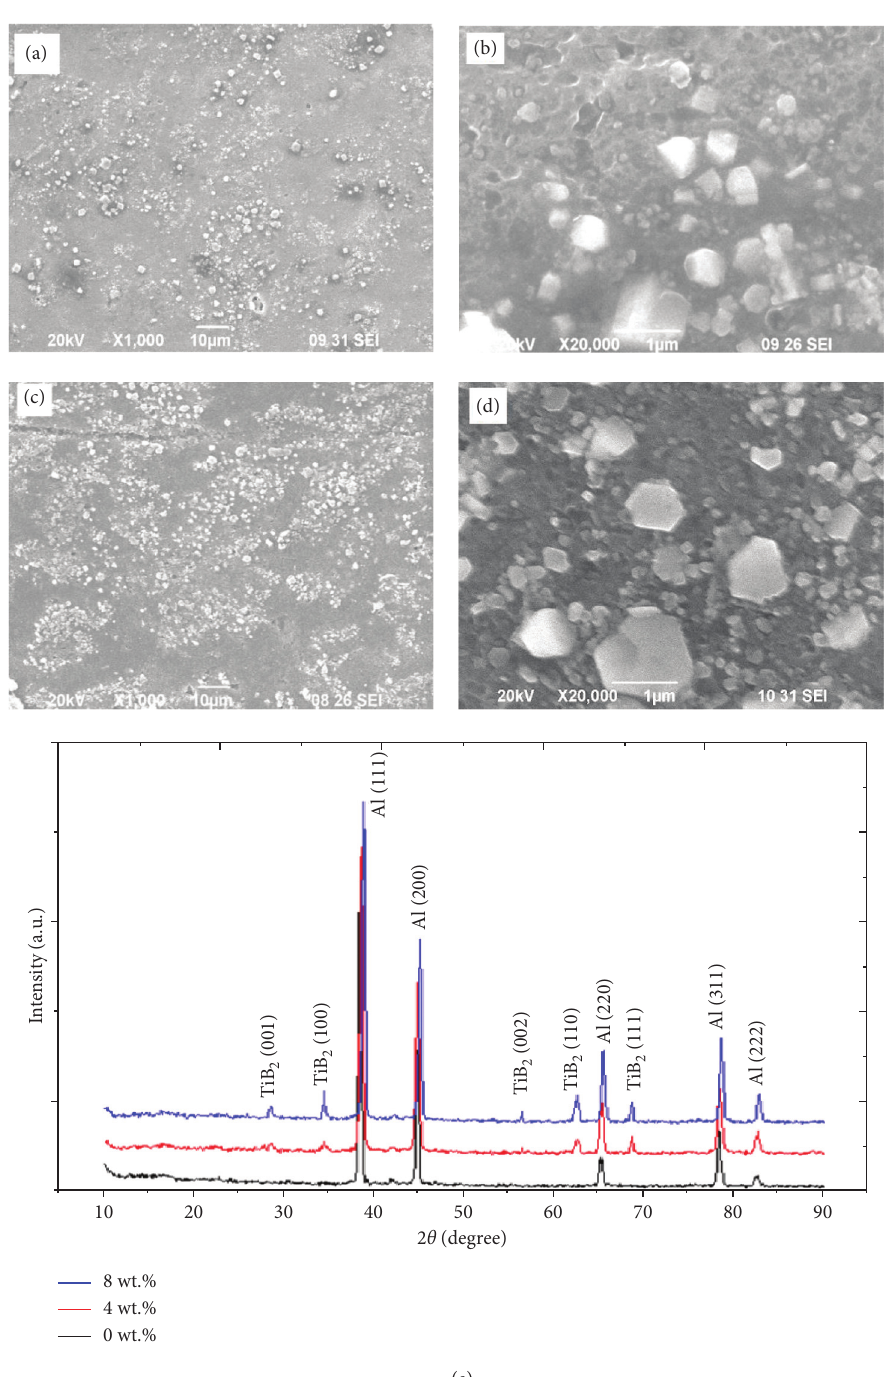
Figure 13: SEM micrograph of AA6351/TiB 2 AMCs containing: (a) 4% TiB 2 , (b) 4% TiB 2 , (c) 8% TiB 2 , (d) 8% TiB 2 , and (e) XRD patterns of AA6351/TiB 2 in situ composites